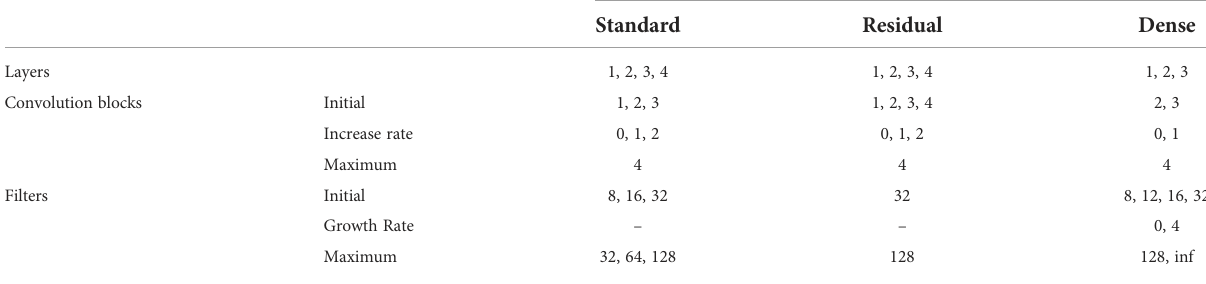
TABLE 2 Investigated architectural hyper-parameters for each architectural